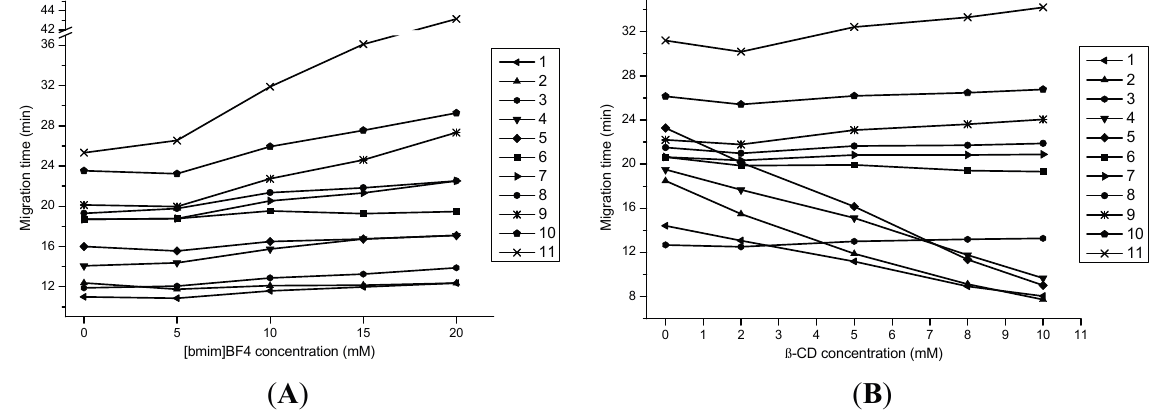
Figure 3. Effects of [bmim]BF 4 and β -CD concentration on migration behavior of the investigated analytes. Conditions: ( A ) 15 mM sodium tetraborate–10 mM SDS–5 mM β -CD containing 15% ACN ( v / v ) at pH 9.8 with different concentrations of [bmim]BF 4 ; ( B ) 15 mM sodium tetraborate–10 mM SDS–10 mM [bmim]BF 4 containing 15% ACN ( v / v ) at pH